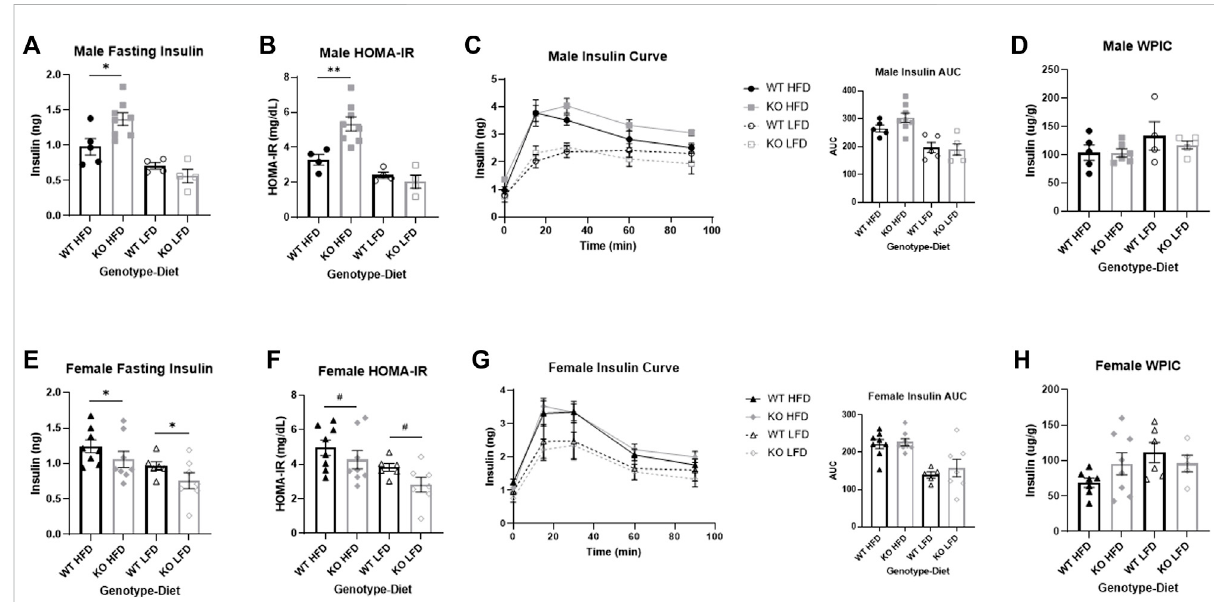
FIGURE 7 Sexdifferencesininsulinresponsebetweenwild-type (WT,black) and Krtcap3 knock-out(KO,gray)male(top)andfemale(bottom)rats.Insulin wasmeasuredinserumcollectedfromtheintraperitonealglucosetolerancetestat12 weeksondiet,andwholepancreasinsulincontent(WPIC)was measured per gram pancreas collected at euthanasia. (A) There was a signi fi cant genotype-by-diet interaction in male rats such that KO males (square) had a higher fasting insulin than WT males (circle) only on a high-fat diet (HFD; fi lled), not a low-fat diet (LFD; empty). * p < 0.05 for an effect of genotype in the HFD condition. (B) There was a genotype-by-diet interaction for homeostatic model assessment of insulin resistance (HOMA-IR)in male rats such that KO males had a higher HOMA-IR score than WT males only when on a HFD. ** p < 0.01 for an effect of genotype in the HFD condition. (C) There were no signi fi cant differences in insulin area-under-the-curve (AUC) between WT and KO males. (D) There were no signi fi cant differences in WPIC between WT and KO males. (E) KO females (diamond) on both diets had a lower fasting insulin than WT females (triangle). * p < 0.05 for amain effect ofgenotype. (F) KO females had atrend towarda lower HOMA-IR score compared to WT females. # p < 0.1for a main effect of genotype. (G) There were no differences, however, in insulin AUC between WT and KO females and (H) there were no signi fi cant differences in WPIC between WT and KO females of either diet. Diet effects are reported in the “ Results ”